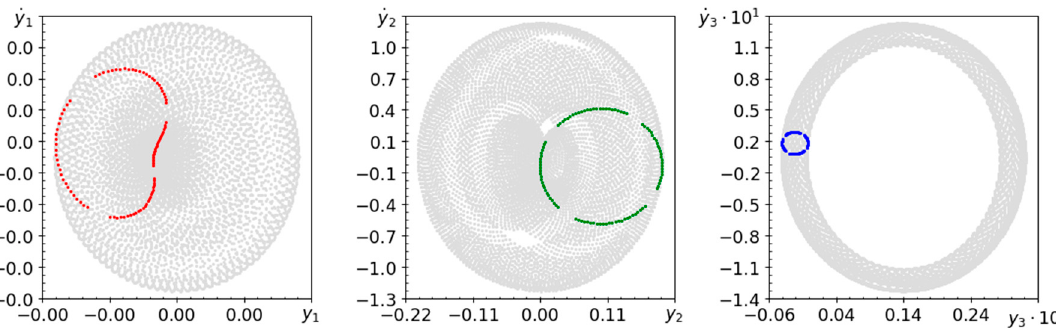
Figure 20. Phase planes and Poincar é maps (colors as above) for C = 0.05, k = 2000 and ω = Figure 20. Phase planes and Poincaré maps (colors as above) for (cid:1829) = 0.05 , (cid:1863) = 2000 and (cid:2033) = 7.24 . Figure 20. Phase planes and Poincaré maps (colors as above) for (cid:1829) = 0.05 , (cid:1863) = 2000 and (cid:2033) = 7.24 . Figure 20. Phase planes and Poincaré maps (colors as above) for (cid:1829) = 0.05 , (cid:1863) = 2000 and (cid:2033) = 7.24 . Table 7. Spectra of Lyapunov exponents for the system with elastic pendulum. Table 7. Spectra of Lyapunov exponents for the system with elastic pendulum. Table 7. Spectra of Lyapunov exponents for the system with elastic pendulum. Parameters Parameters Parameters